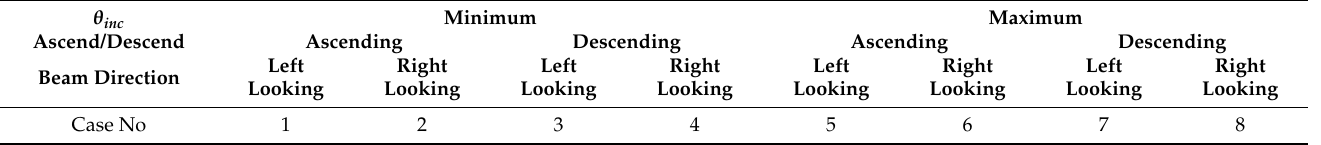
Figure 14. Flowchart of the autonomous attitude-control algorithm for multistatic SAR imaging with the 𝑅𝐴𝐷𝑁 (cid:3042)(cid:3043) concept applied. When the attitude calculation of the SAR mode is completed, the attitude control starts from the sun-pointing mode to the SAR-imaging mode 10 min before 𝑒𝑝𝑜𝑐ℎ (cid:3020)(cid:3002)(cid:3019) . This lead time of 10 min is set in consideration of the time taken to change the attitude at 2°/s